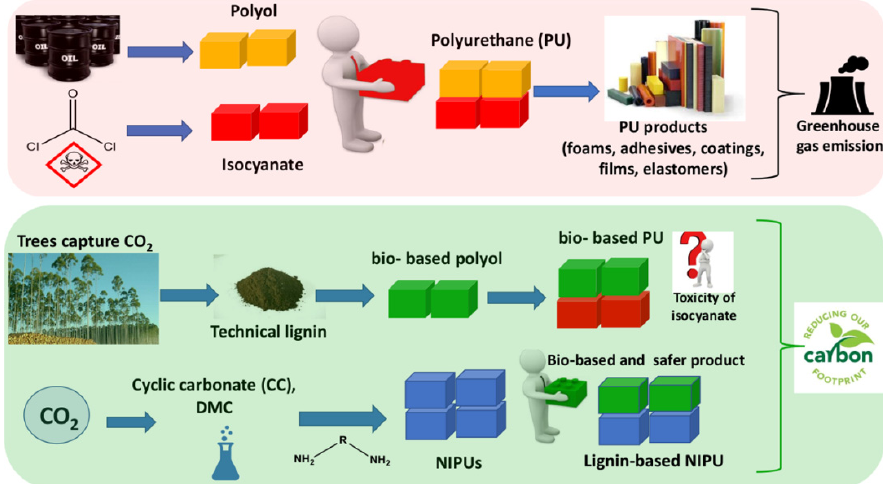
Figure 3. Lignin as a renewable building block to produce sustainable